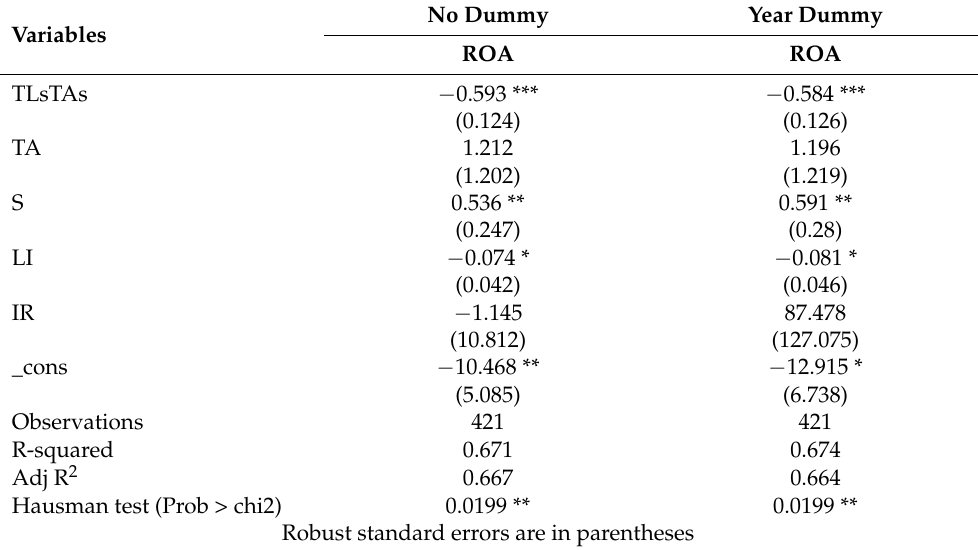
Table 10. Results of the Fixed Effects of TLsTAs on ROA, as per Panel Data